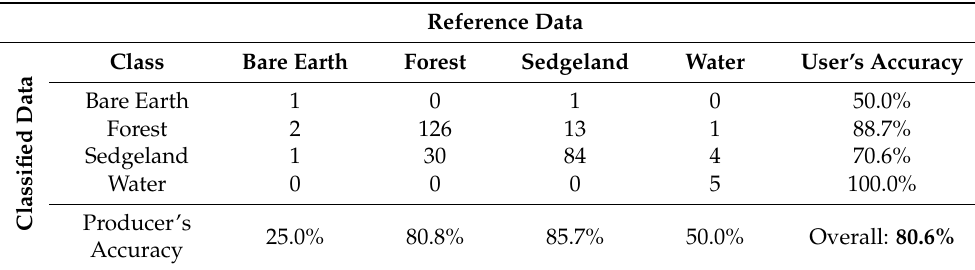
Table 5. Confusion matrix for image-only data stream describing vegetation